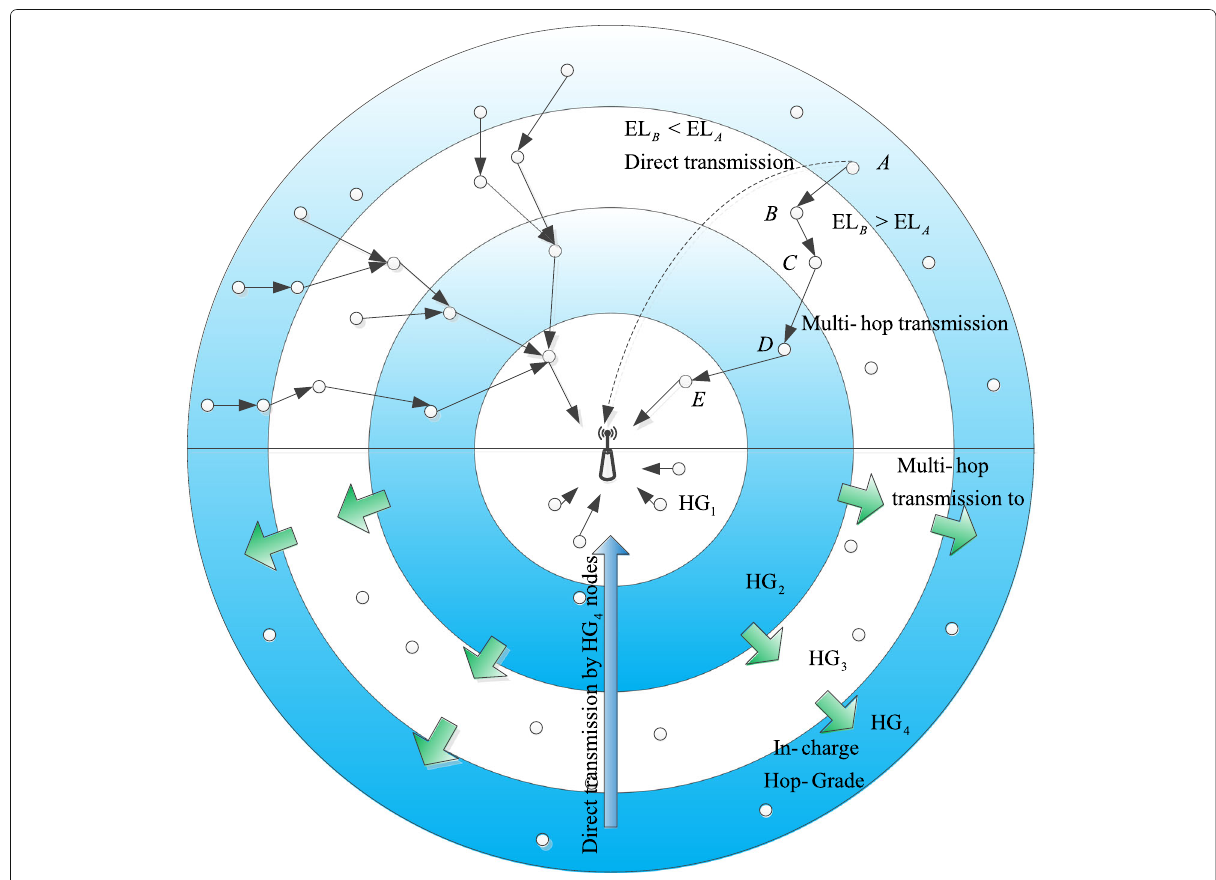
Fig. 1 Data transmission in BTM and UDAR